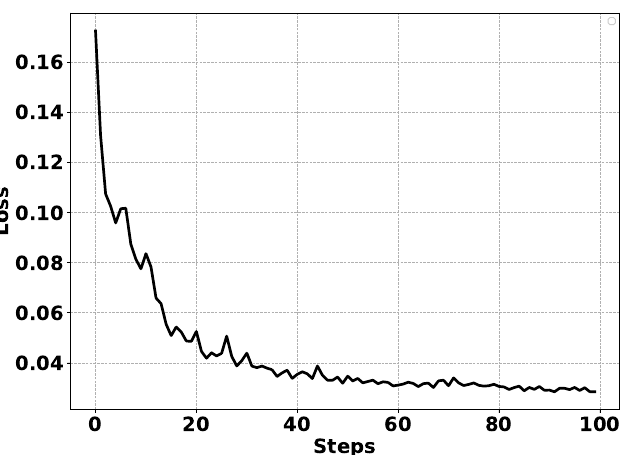
Figure 7. The result of loss before